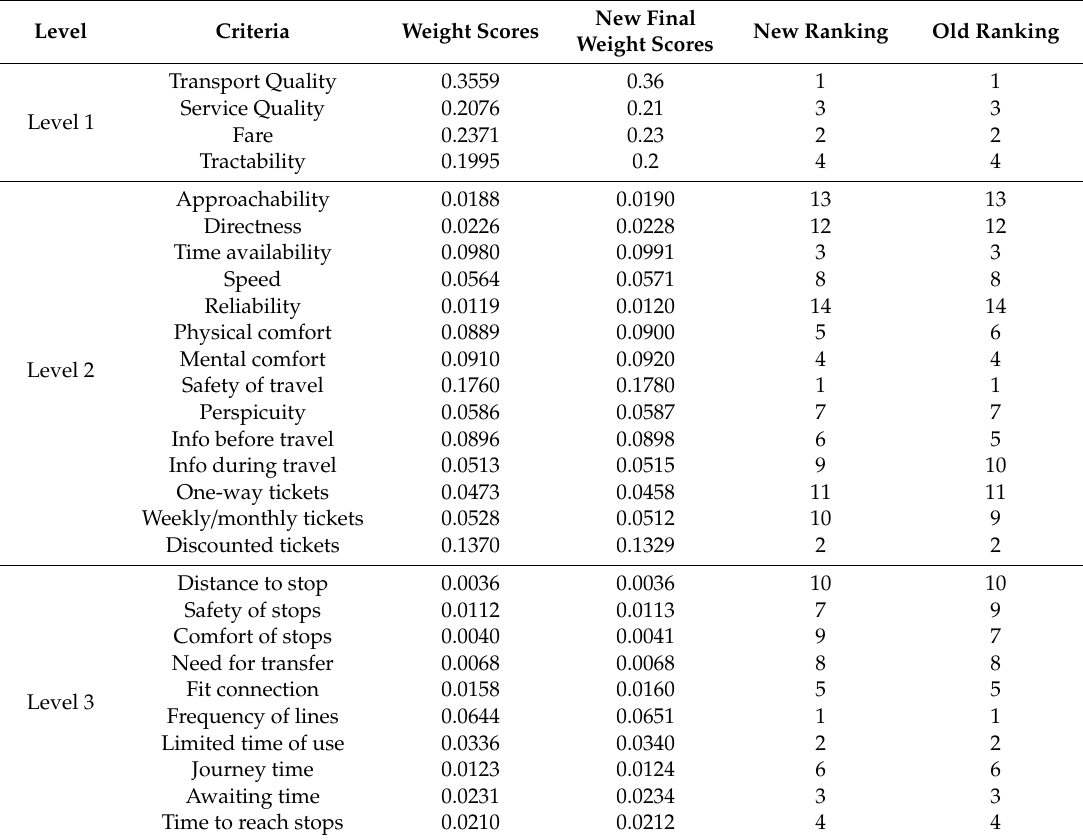
Table 10. Weight scores and ranking after the sensitivity check for passengers’